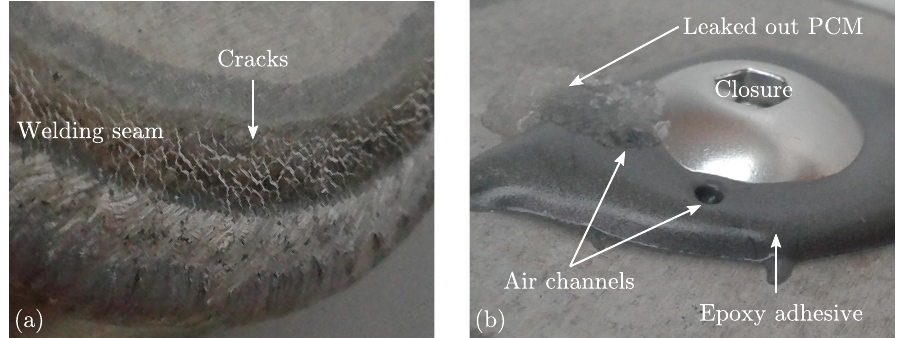
Figure 5. Summary of failed sealing methods for aluminium capsules. ( a ) Welded closure; ( b ) Glued closure;